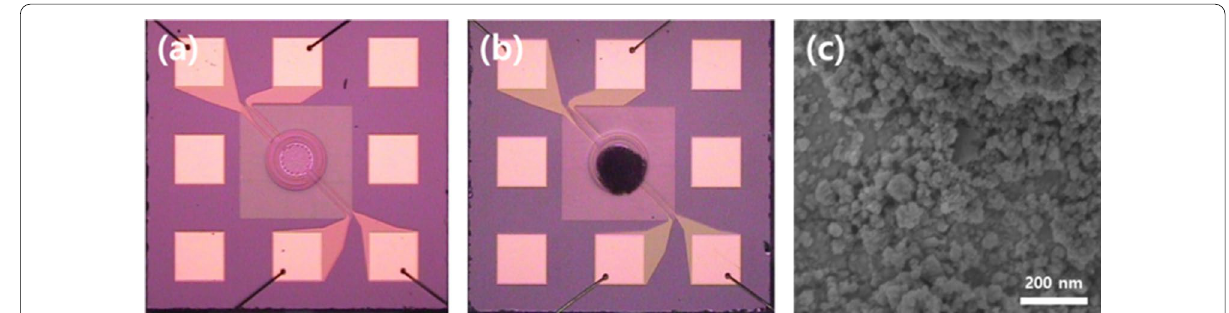
Fig. 3 Optical images of MEMS microheater ( a ), with deposition of sensing materials ( b ) and SEM image of deposited sensing material on MEMS microheater ( c